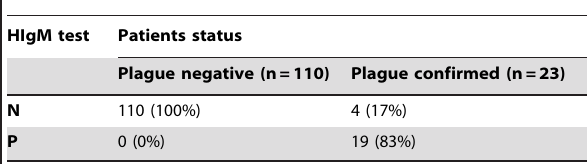
Table 2. Use of HIgM test for plague